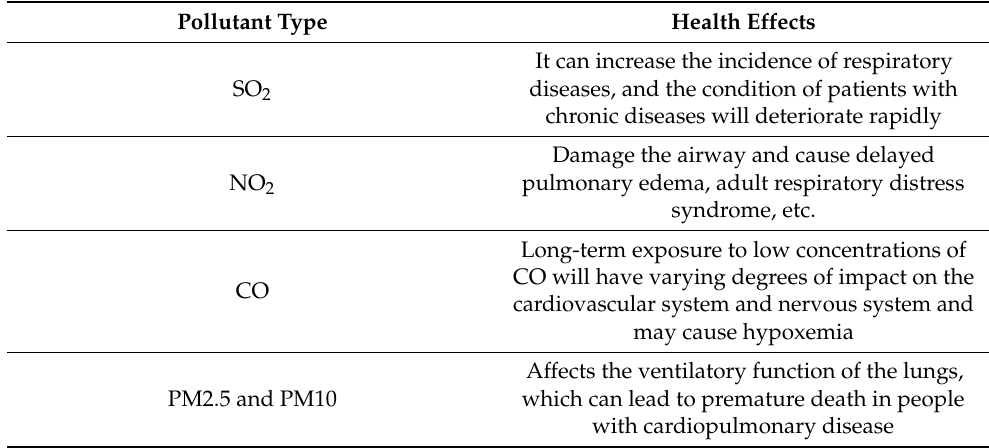
Table 2. Common air pollutants and their impact on health.